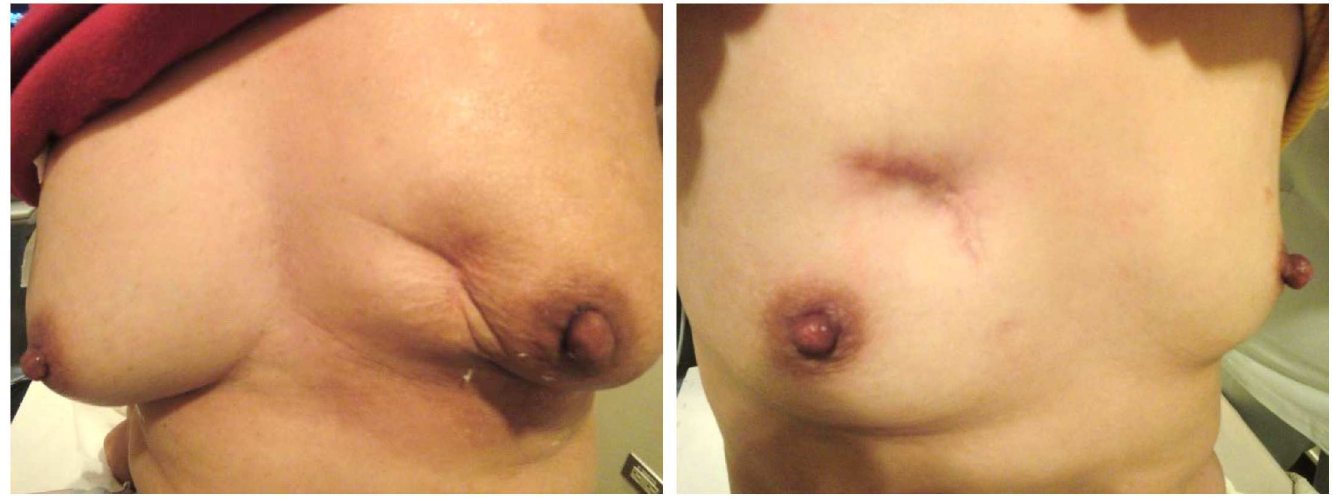
Fig 1. Two representative cases of breast deformity after extensive excisions in the upper inner